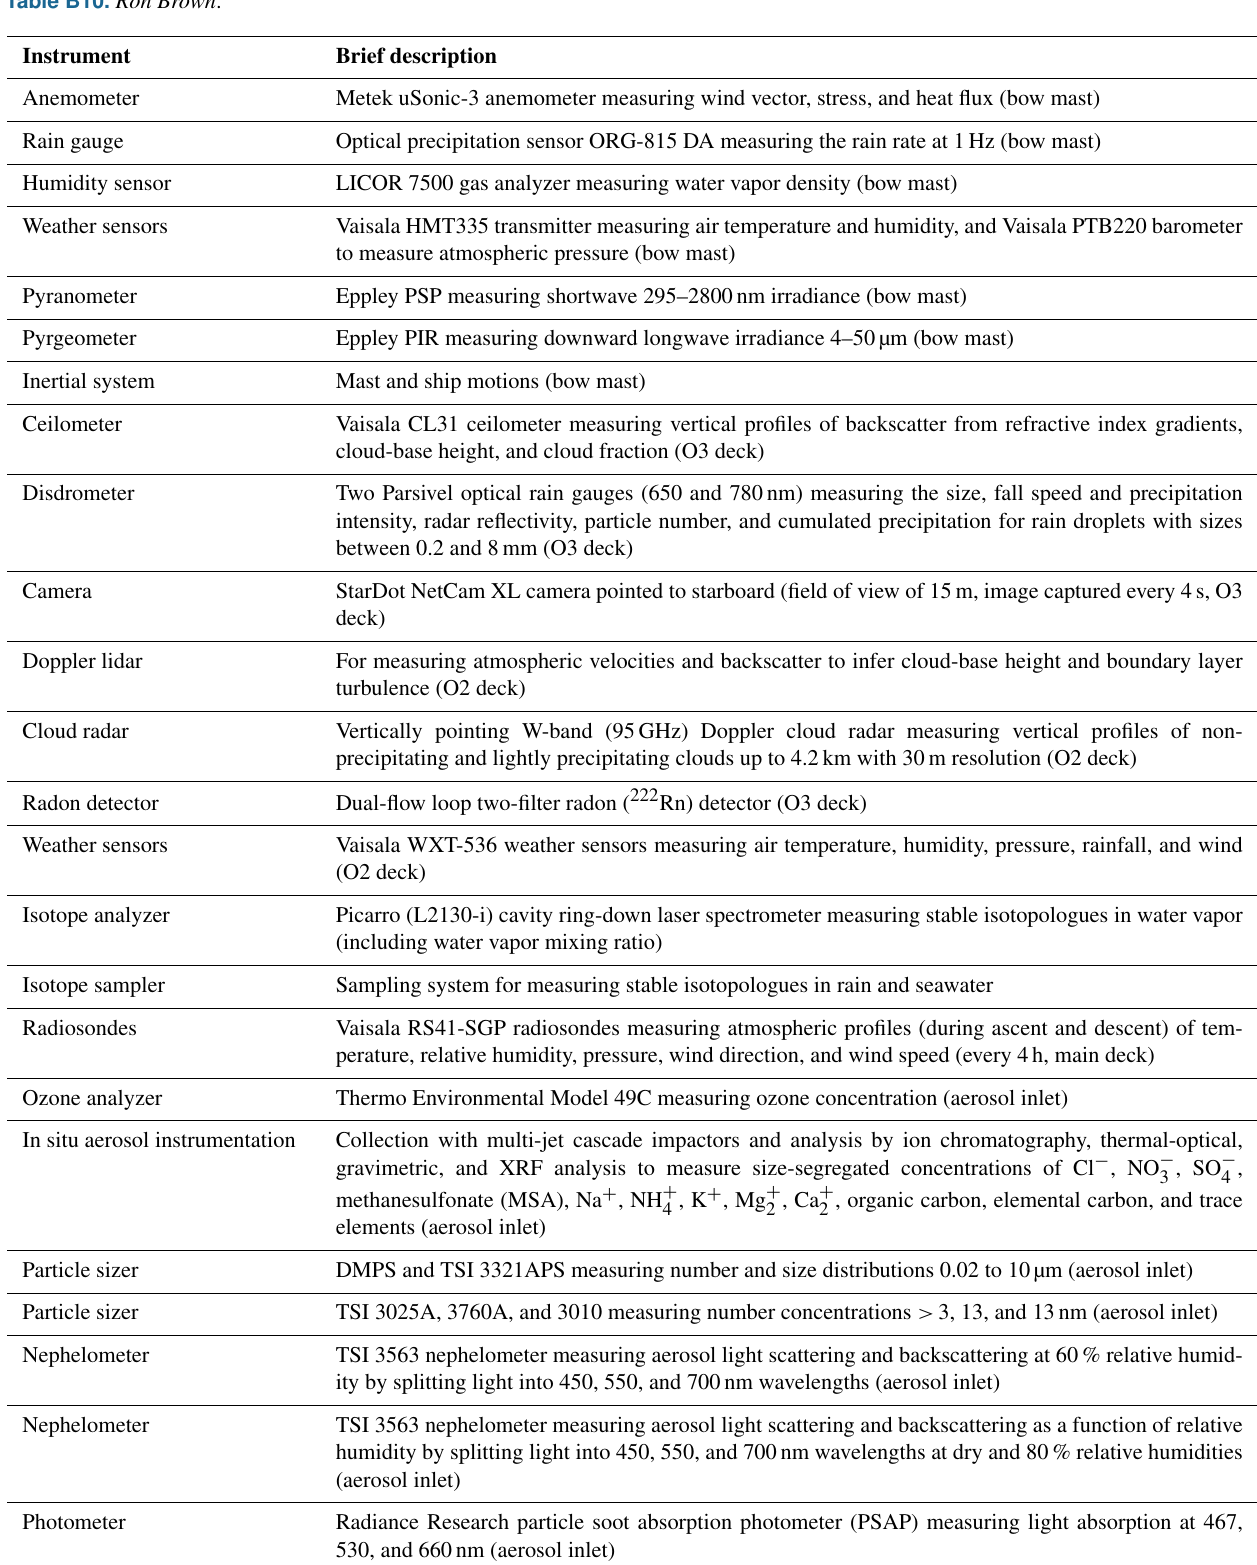
Table B10. Ron Brown .